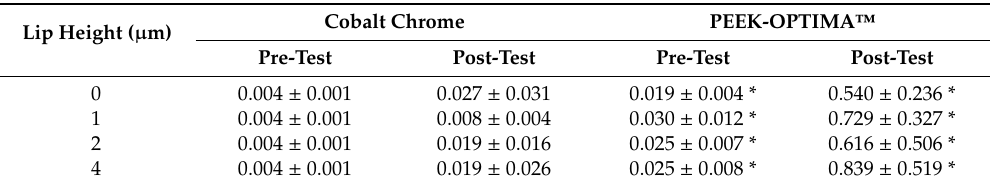
Table 3. Mean surface roughness (Ra), µ m ( ± 95% confidence limits) of PEEK-OPTIMA ™ and cobalt chrome plates taken perpendicular to the direction of wear simulation (B) pre- and post- wear testing. Statistical analysis to compare PEEK to CoCr, * denotes p <